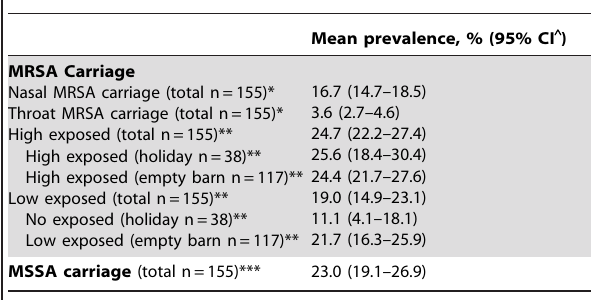
Mean prevalence, % (95% CI ‘